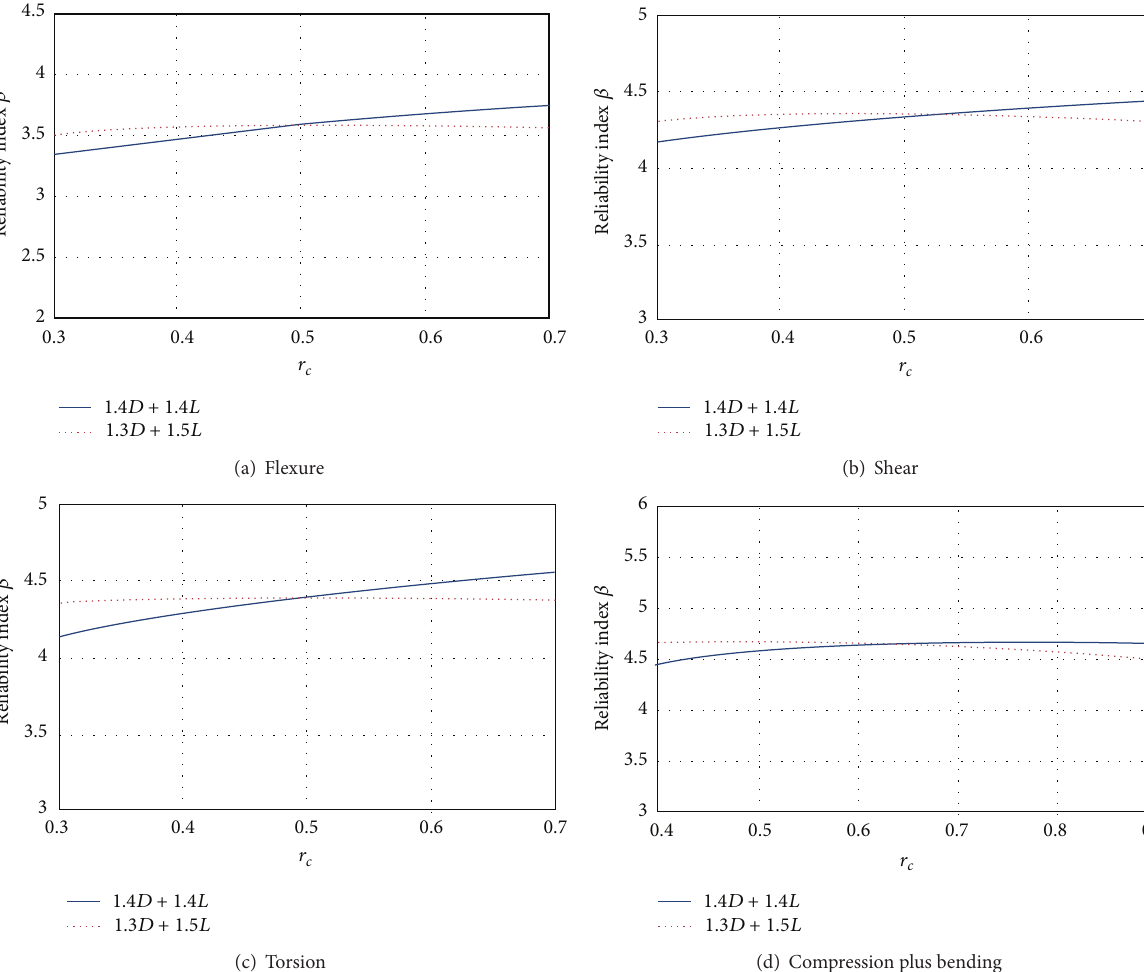
Figure 15: Reliabilities obtained with the 𝛾 combination recommended by RCDF-04 and with the 𝛾 combination proposed in this